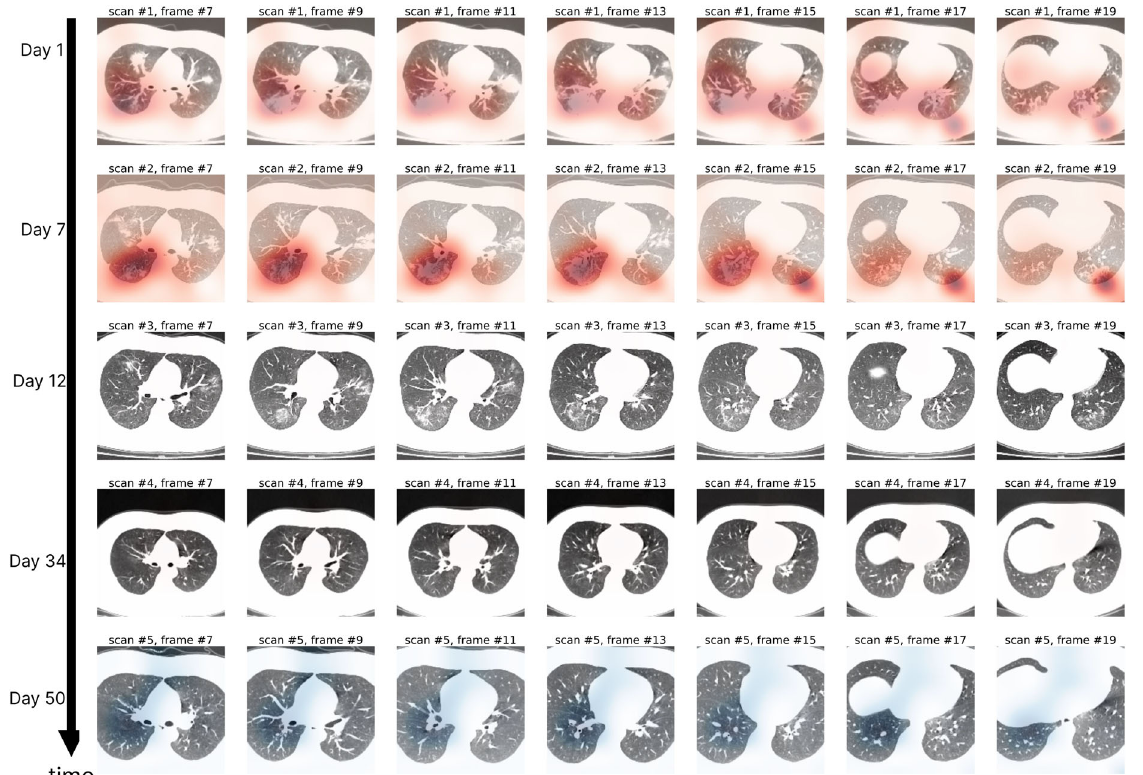
Fig. 12 Case study using DCD on a follow-up patient (24 years old) with 5 scans. This patient was discharged on day 13. Modi fi ed gradient heat maps, H ( x , y , z , t ) for all pixel coordinates ( x , y , z ), are superimposed onto the original CT, and color-coded (red for H ( x , y , z ) > 0 and blue for H ( x , y , z ) < 0). The model was originally trained on task 1 and evaluated on these unseen examples. Severity predicted by DCD was highest on day 7 (as indicated by the visual difference between H on day 7 and day 1). On day 12, DCD ’ s H ( x , y , z , t = 12) ≈ 0 indicates signi fi cant recovery.